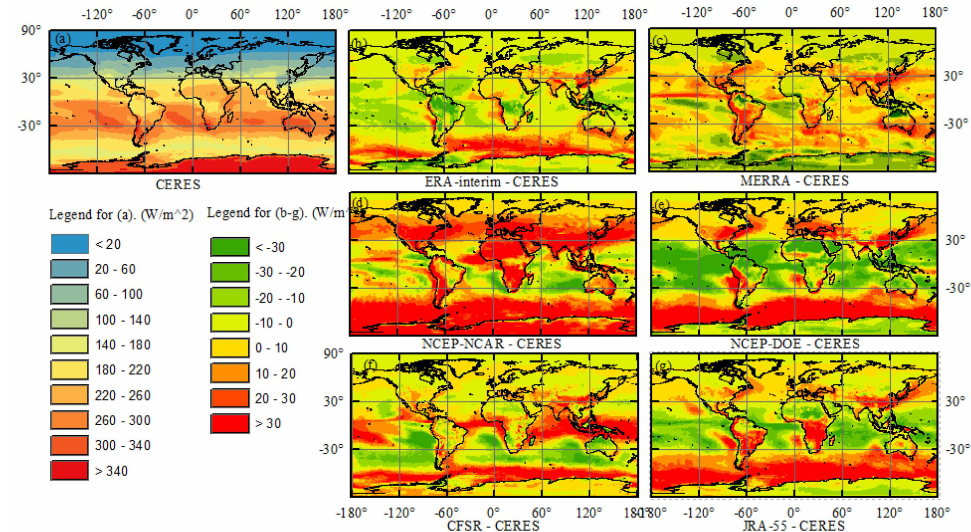
Figure 4. CERES-EBAF monthly R s climatologies for DJF and the biases between the reanalyzed R s product and the CERES-EBAF R s product (reanalysis minus CERES) from 2001 to 2009: ( a ) CERES monthly Rs for DJF; ( b ) ERA-Interim minus CERES; ( c ) MERRA minus CERES; ( d ) NCEP-NCAR minus CERES; ( e ) NCEP-DOE minus CERES; ( f ) CFSR minus CERES; ( g ) JRA-55 minus CERES.